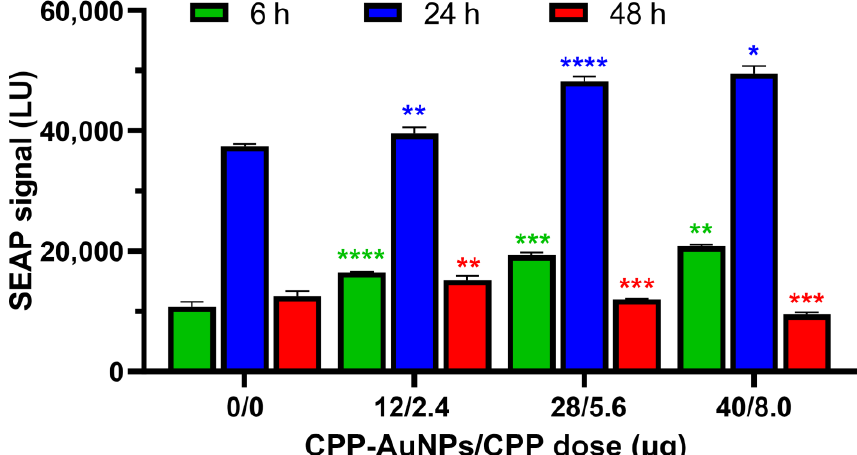
Figure 3. SEAP levels in the SEAP-ARPE-19 cell supernatants (mean ± SD, n = 5) over different time periods after transfection with CPP-AuNPs in Opti-MEM. For statistical analysis, see Table S1. The statistical significance are denoted by: *— p ≤ 0.05; **— p ≤ 0.01; ***— p ≤ 0.001; ****— p ≤ 0.0001.